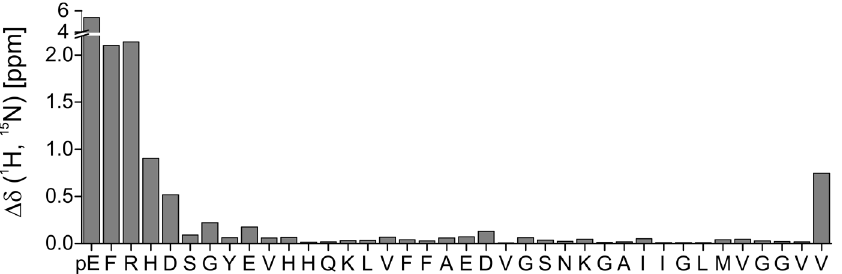
Fig 5. Chemical shift changes Δδ ( 1 H, 15 N) = ((10 * Δδ 1H N ) 2 + ( Δδ 15 N) 2 ) 1/2 between pEA β (3 – 40) and A β (1 – 40) plotted as a function of the pEA β (3 – 40) sequence. Pyroglutamate formation affects the N-terminal amino acids with decreasing effect towards the C-terminus and, interestingly, also the C-terminal